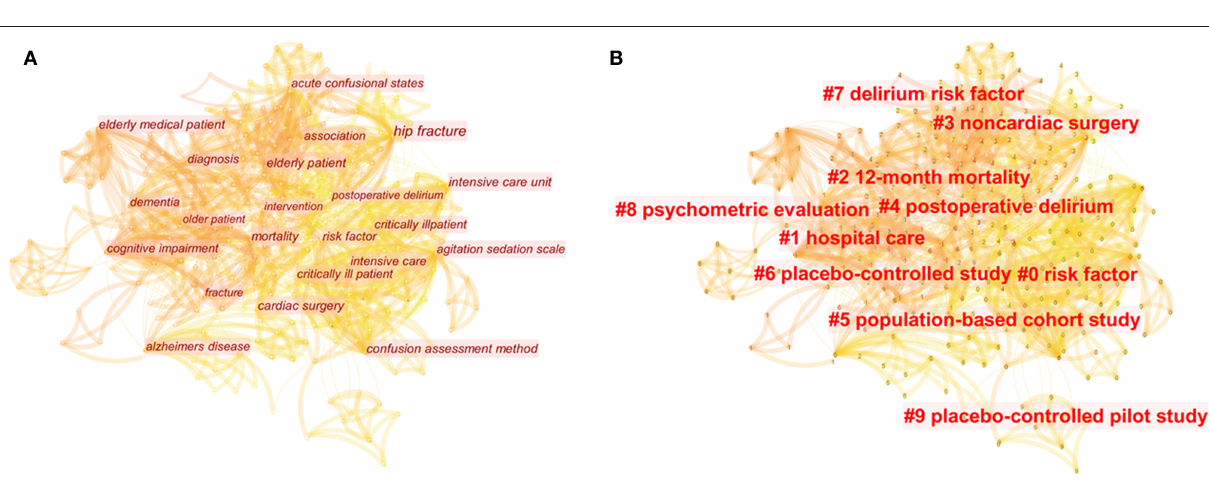
FIGURE 4 | Keyword visualization analysis of the 100 most-cited articles in the field of delirium. (A) The map of keywords co-occurrence analysis. (B) The map of keywords cluster